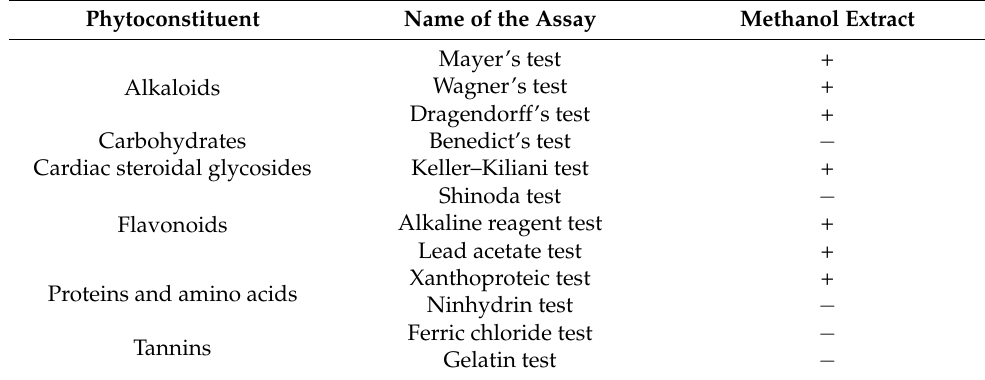
Table 1. Phytochemical screening of methanol leaf extract of Skimmia anquetilia